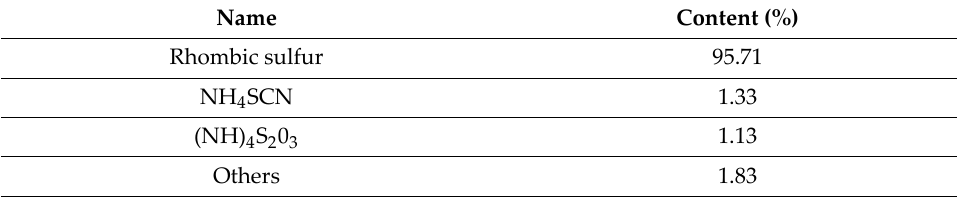
Table 3. Main components and content of sulfur.